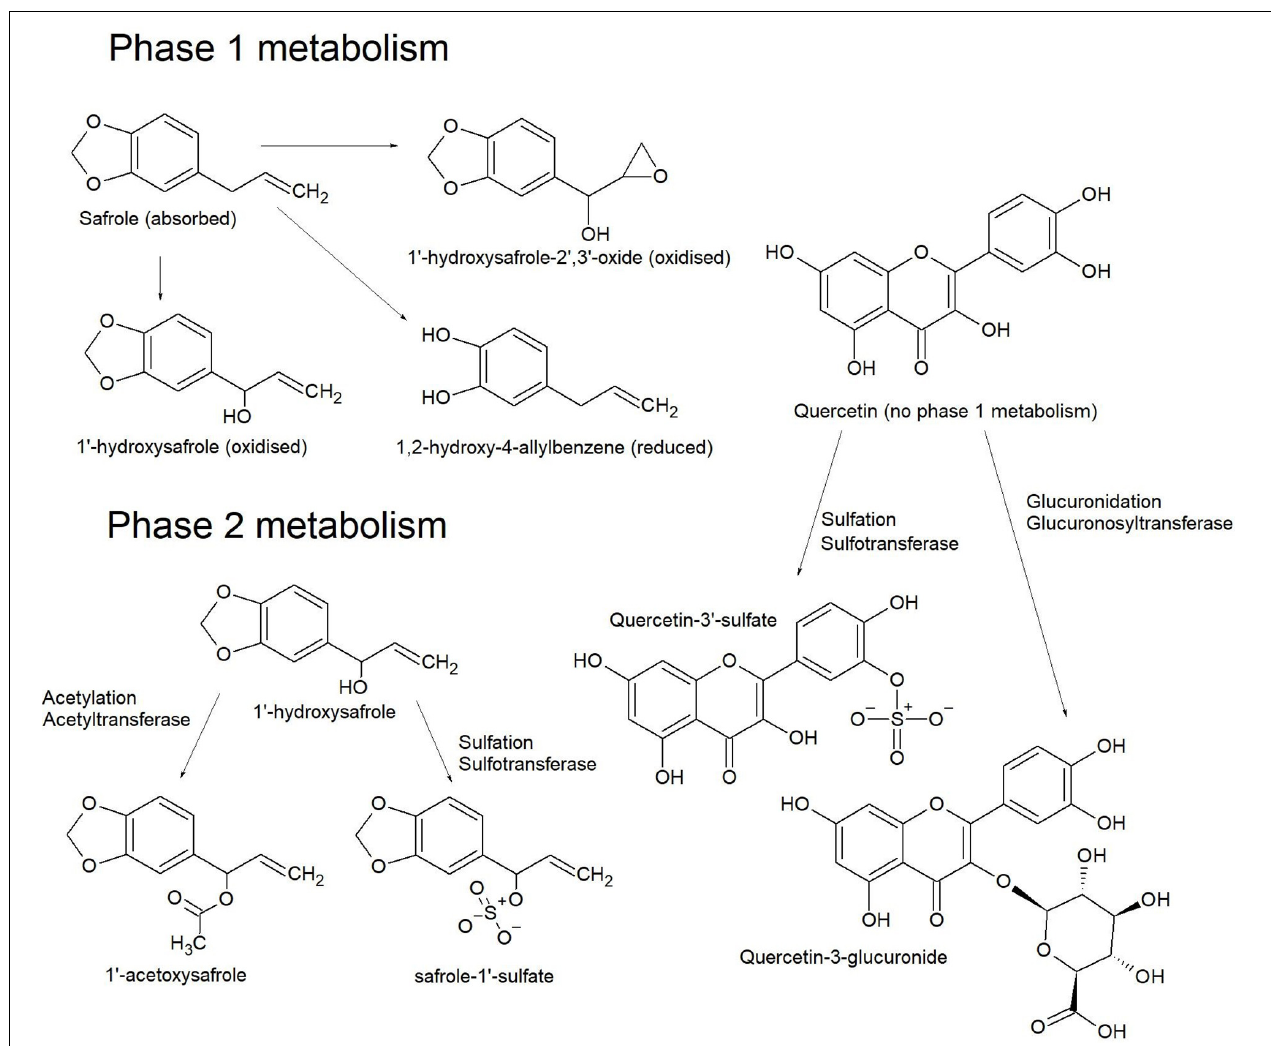
FIGURE 9 | Phase 1 metabolism of safrole produces a number of hydroxylated derivatives, but quercetin is less commonly derivatized at this step. Phase 2 metabolism of 1’-hydroxysafrole produces acetoxy and sulfate derivatives where the hydroxyl ‘handle’ from phase 1 metabolism is used to attach the respective conjugates. The two most common conjugates on quercetin are a sulfate at the 3’ OH or at the 3 or 7 OH for glucuronic acid (O’Leary et al., 2003).